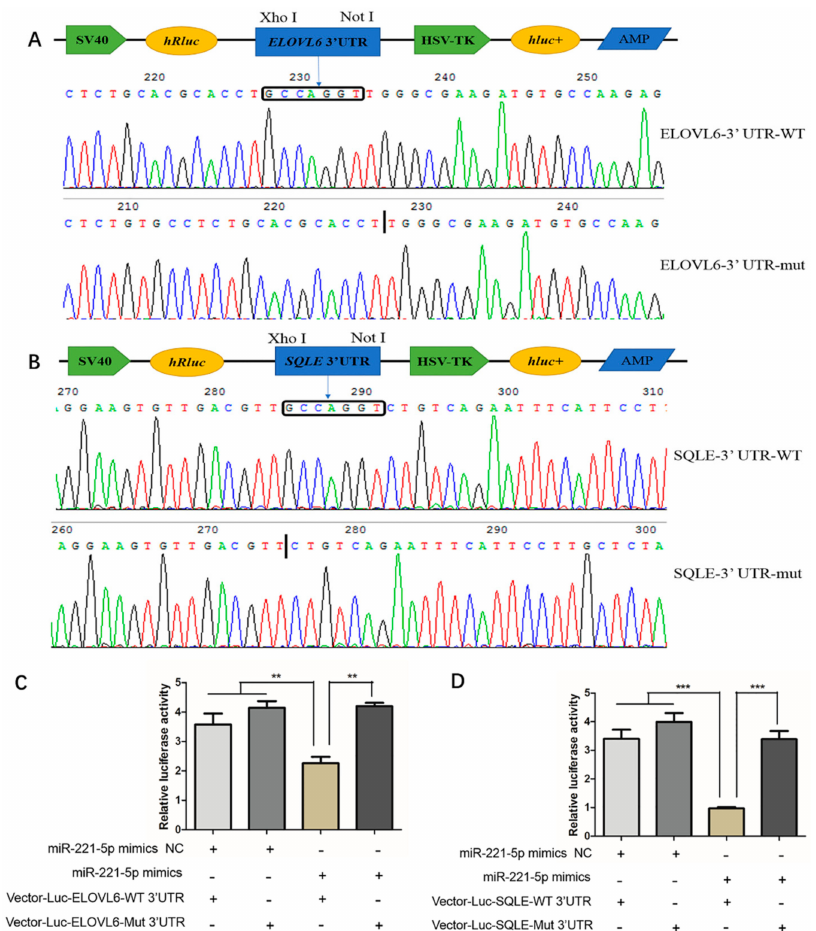
Figure 6. Validation of gga-miR-221-5p and the ELOVL6 and SQLE targeting relationship. ( A , B ) Recombinant plasmid sequencing. ( C , D ) Dual luciferase reporter assay analysis of the target relationship of gga-miR-221-5p with ELOVL6 and SQLE in LMH chicken hepatoma cells. The long box (cid:3) indicates the position of the gga-miR-221-5p seed region in combination with the ELOVL6 and the SQLE gene 3 (cid:48) UTR, the black vertical line indicates the position of the ELOVL6 and SQLE gene 3 (cid:48) UTR deletion binding to the gga-miR-221-5p seed region. WT indicates wild, Mut indicates mutation, + indicates added, - indicates not added. Data are represented as mean ± SD ( n = 6). ** means 0.001 < p < 0.01, *** means p <